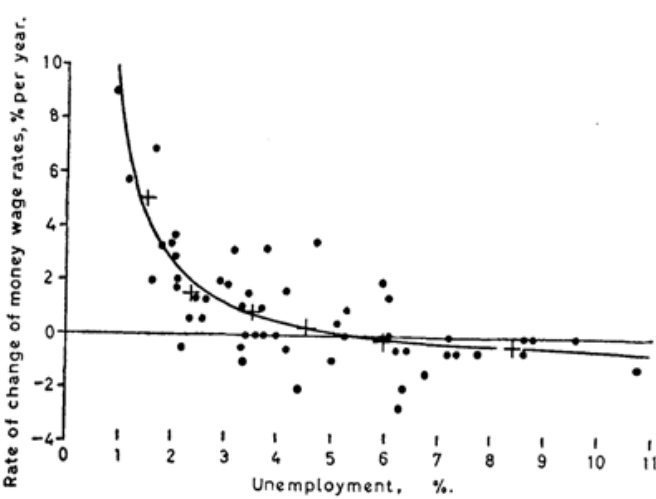
Figure 1. “Original” Phillips curve [3] (with permission from the John Wiley and Sons